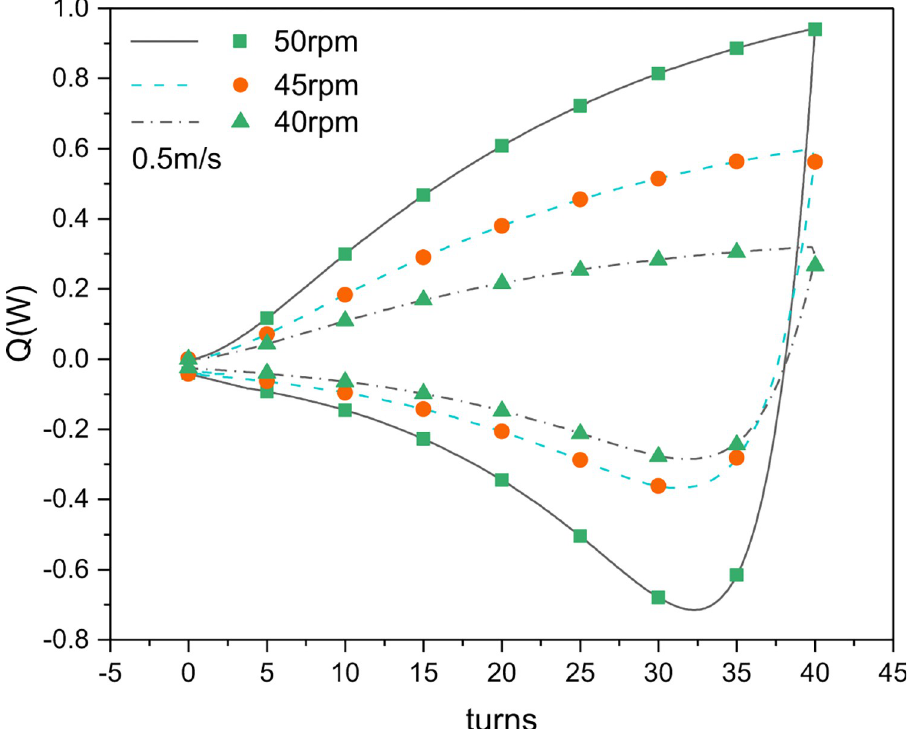
Fig 13. Simulated cooling and heating capacities of a single nitinol wire–stepping motor unit as functions of the stepping motor speed ( n 1